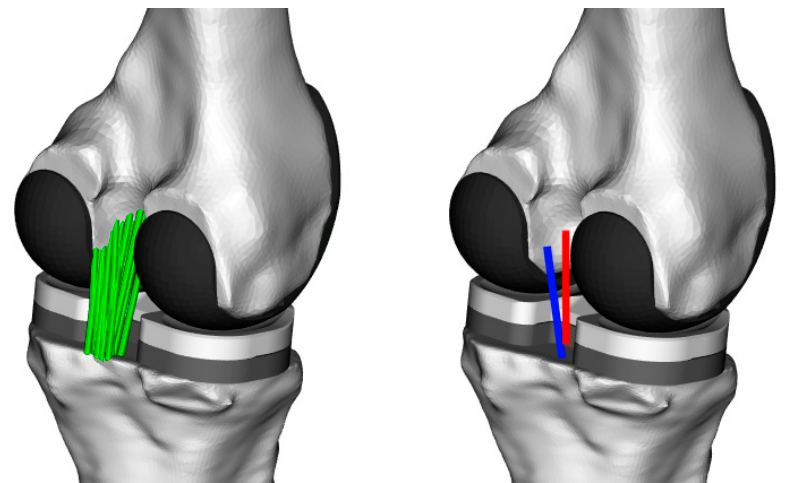
Figure 2. A schematic image of the multibody knee model including two posterior cruciate ligament (PCL) bundles (each represented by 10 fibres) and a 6-degrees-of-freedom (DoF) knee joint ( left ). To summarise bundle function, elongation patterns are reported as the average of the 10 fibres for the anterolateral (AL) (red) and posteromedial (PM) (blue) bundles of the PCL ( right ).